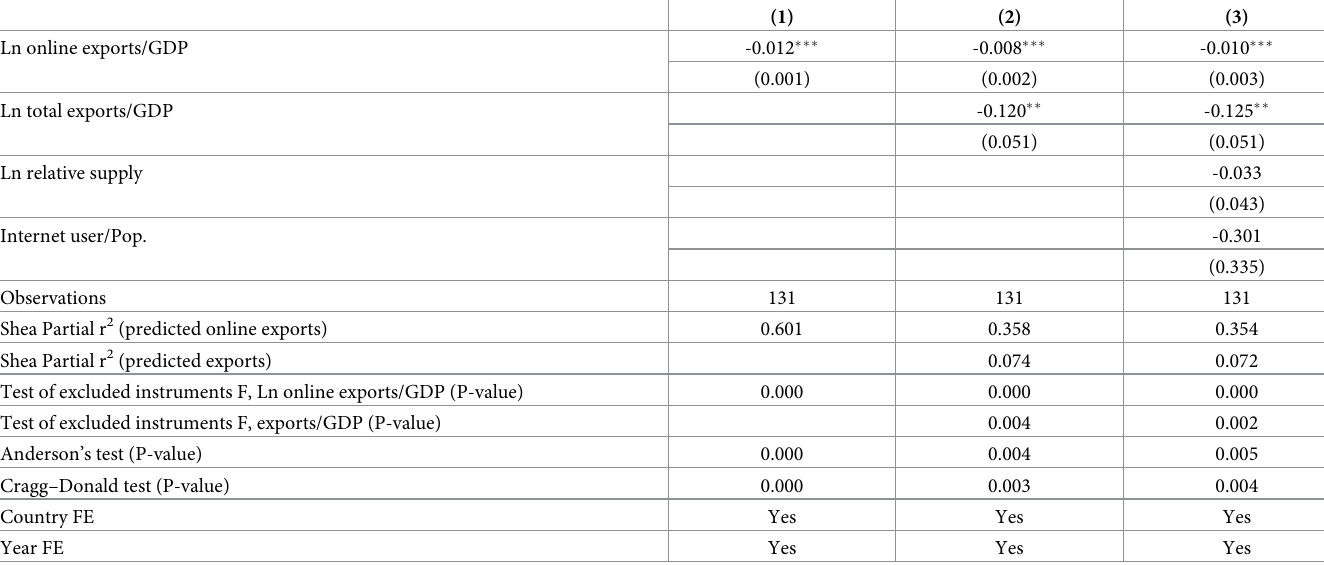
Table 6. Impact of online exports on the wage gap (instrumental